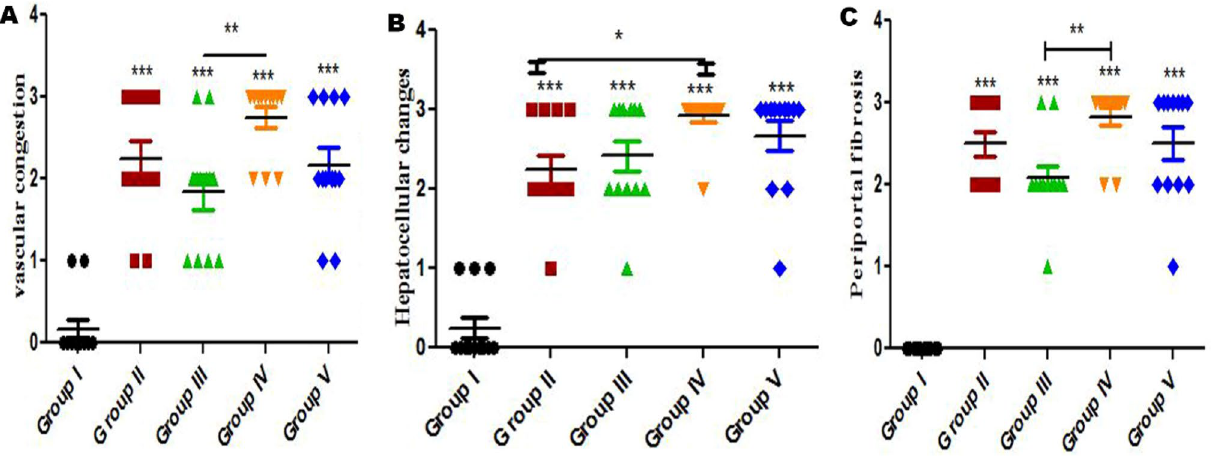
Figure 13. Histomorphometry graph showing the semiquantitative measurements of rats liver alterations between the experimental groups. Plots showing ( A ) vascular congestion, ( B ) hepatocellular changes, and ( C ) periportal fibrosis among the experimental groups. Data were represented as mean ± standard error. Significant differences versus the control Group determined through one-way ANOVA with Tukey’s post hoc test are marked by different asterisks: * P ≤ 0.05, ** P ≤ 0.01, *** P ≤